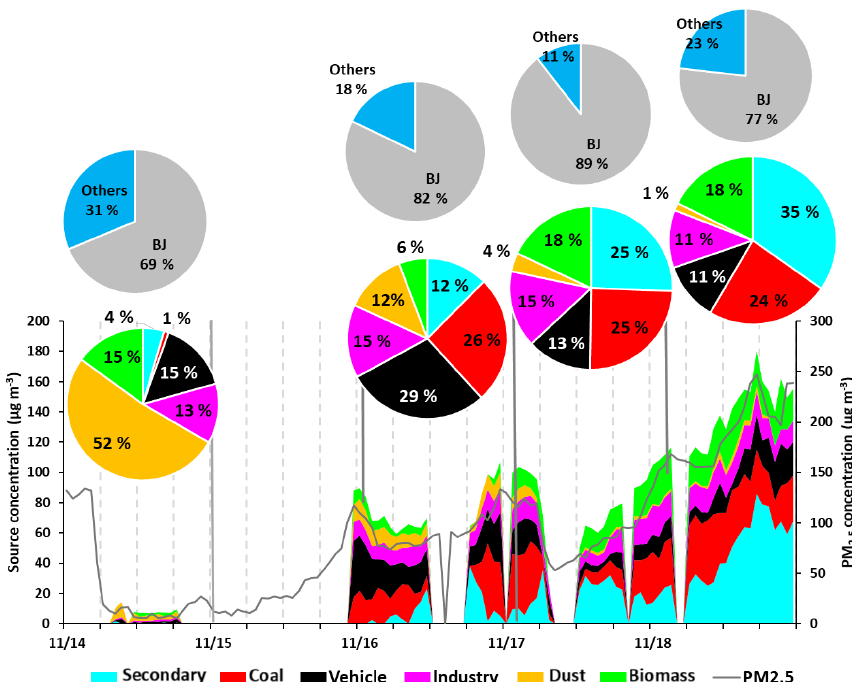
Figure 4. Variation in sources and local contribution during EP1. The above pie charts show the daily local (Beijing as BJ) and regional contributions (labeled “others”). The pie charts below show the daily source type and